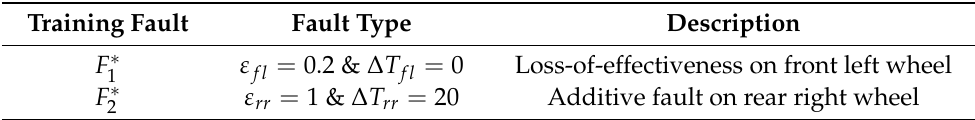
Table 3. Fault types used during